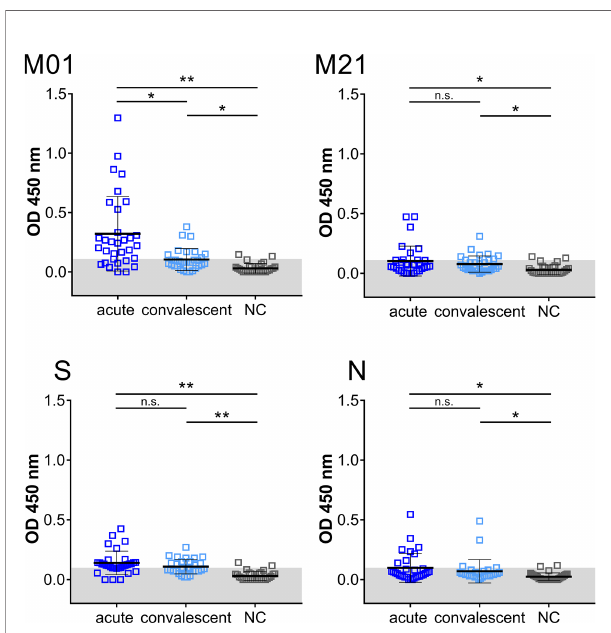
FIGURE 2 | IgM immuno-reactivity obtained with immunodominant peptides in the acute and convalescent phase and negative control group (NC). Each data point represents the OD450 value of one patient. Mean and SD are indicated. The threshold level (mean + 2SD of control) is marked in gray. Data shown is representative of fi ve independent experiments. Asterisk indicates signi fi cance *P < 0.05, **P < 0.0001. n.s., not signi fi